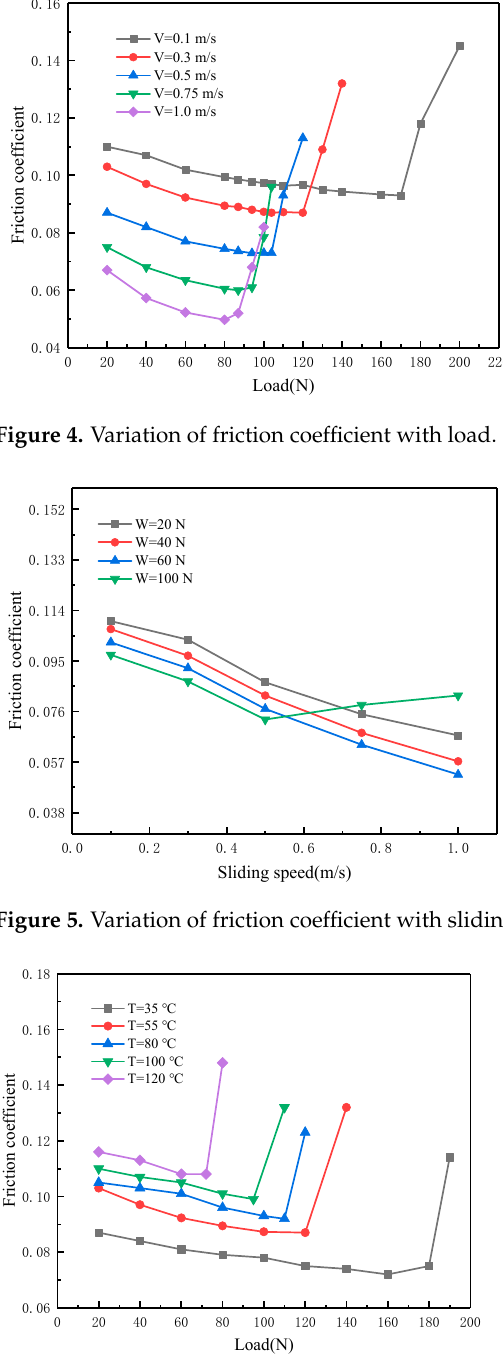
Figure 6. Variation of friction coefficient with temperature.